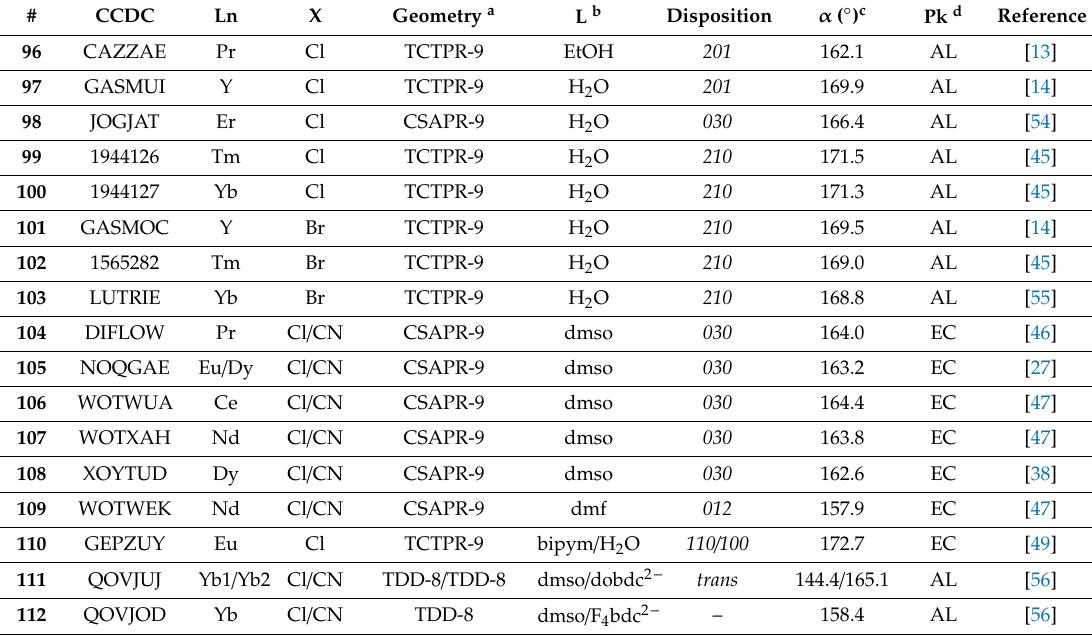
Table 4. Reported Ln-anilato compounds with a rectangular 2D structure and a brick-wall